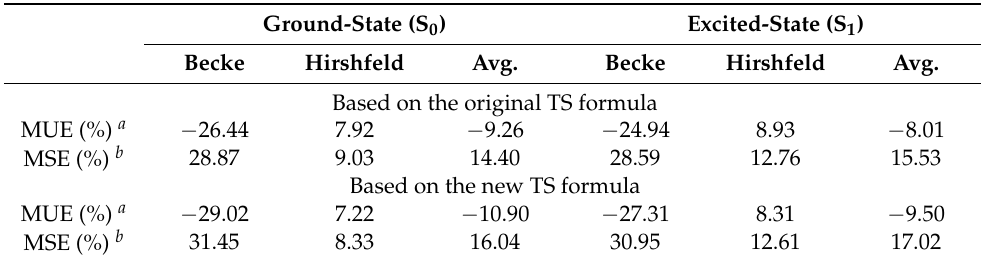
Table 7. Comparison of molecular polarizabilities ( α iso , in Bohr 3 /mol) at S 0 /S 1 predicted by the original and the new TS formula with conventional data as a reference for all the systems in Schemes 1 and